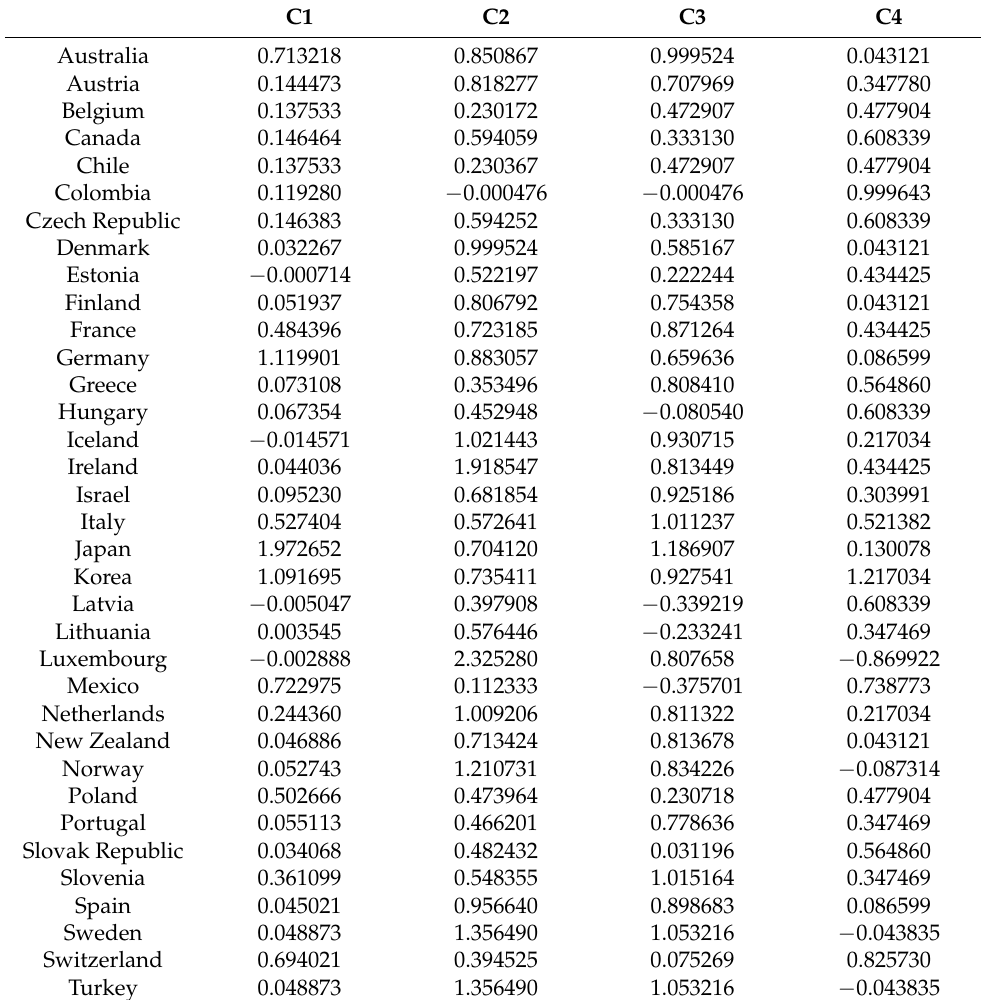
Table 5. The Total Gap Matrix (G ) specifically for the case-study. Their elements (g ij ) are deduced from the difference between the normalized values of Table 2 and the average of each couple of values in Table